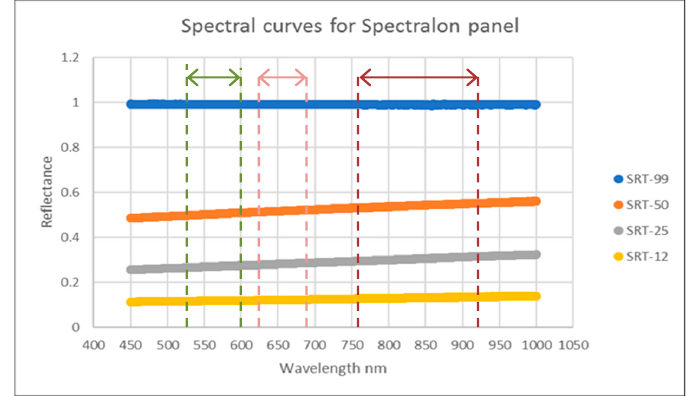
Figure 2. Spectralon multi-step reflectance curves 450–1000 nm at 1 nm intervals.